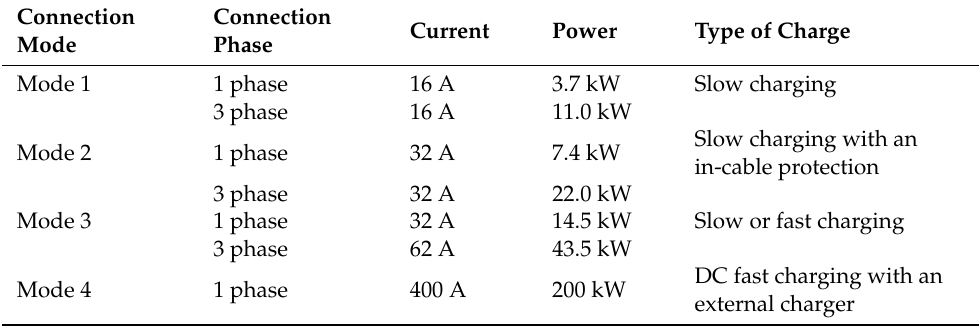
Table 1. EV charging level IEC